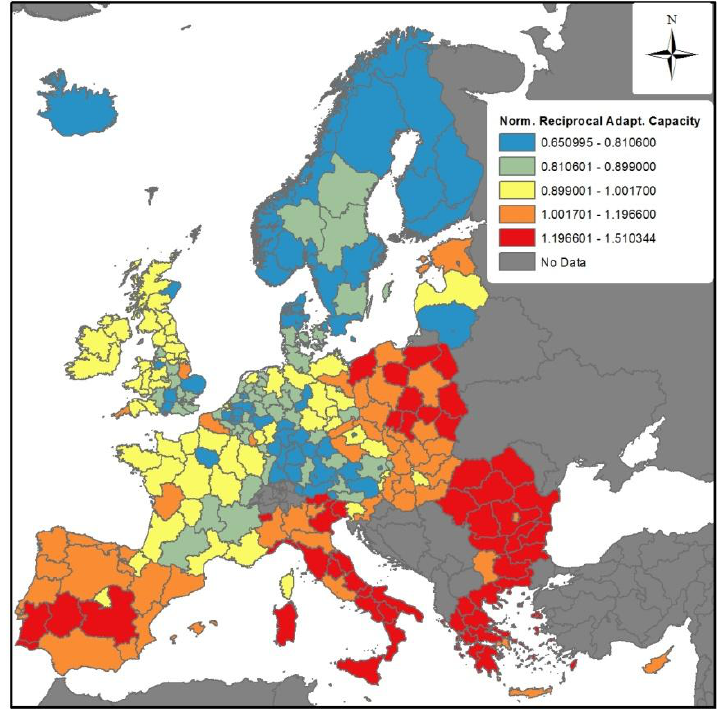
Figure 2. Normalised reciprocal of ESPON Adaptive Capacity